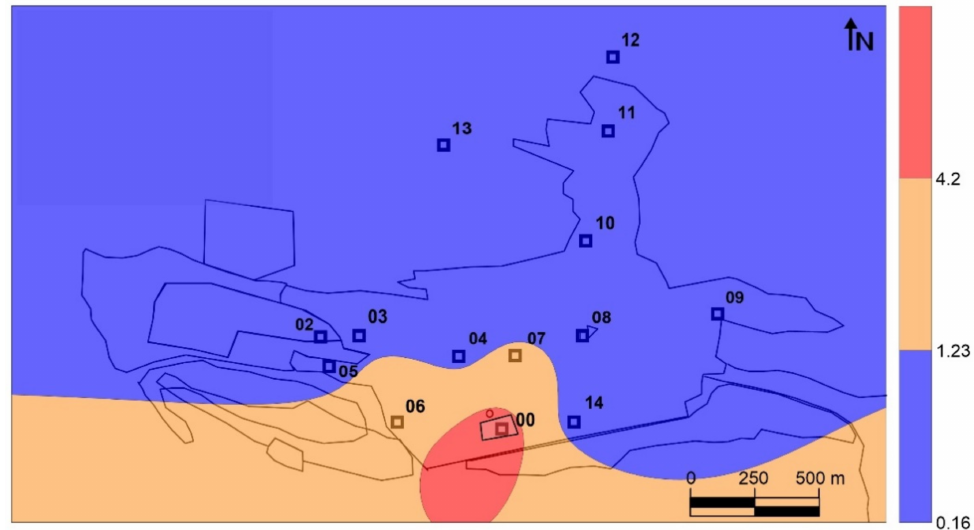
Figure 5. Distribution map of the PBMF obtained as a ratio between THg leaves /THg bark